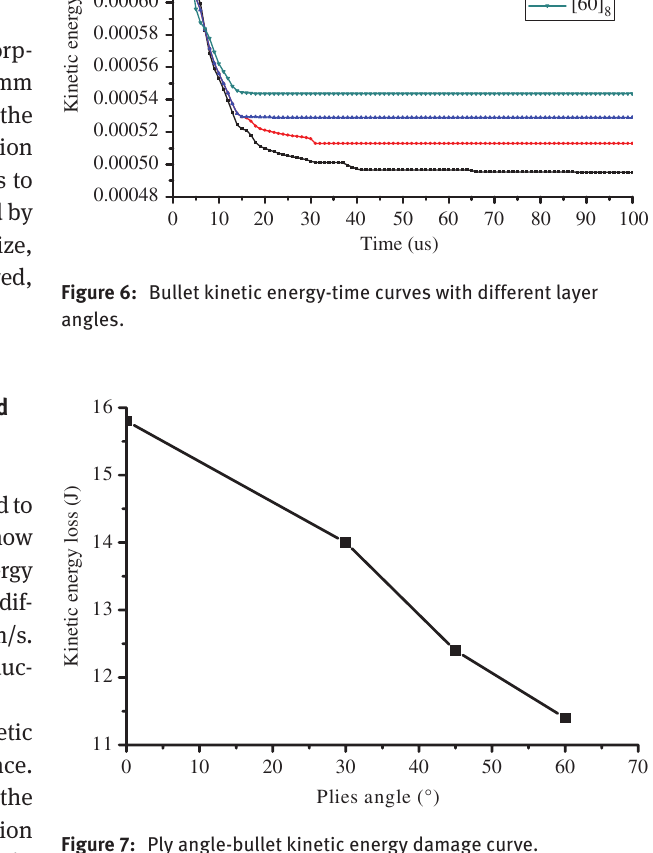
Figure 7: Ply angle-bullet kinetic energy damage